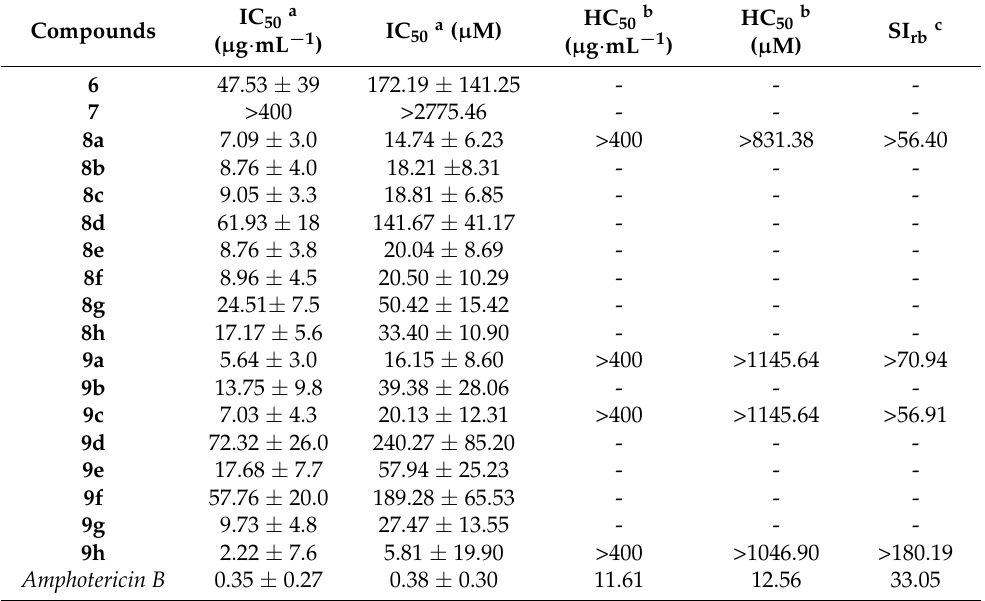
Table 3. In vitro biological